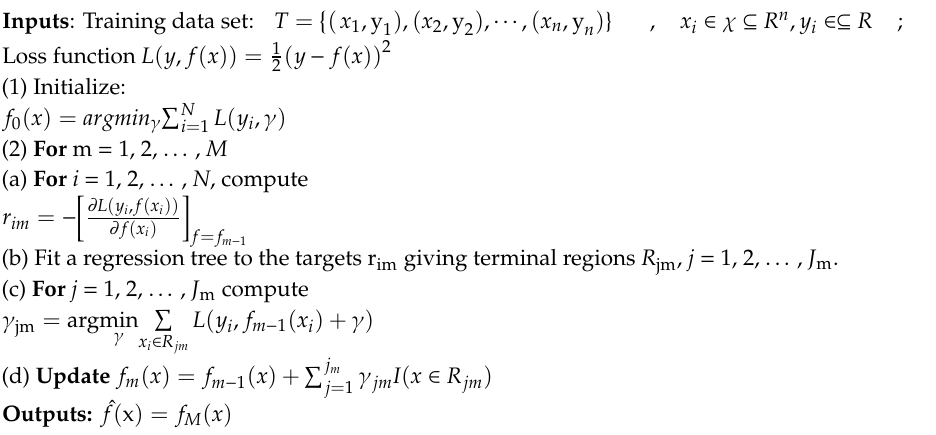
Algorithm 2. Gradient boosting decision tree (GBDT) algorithm.